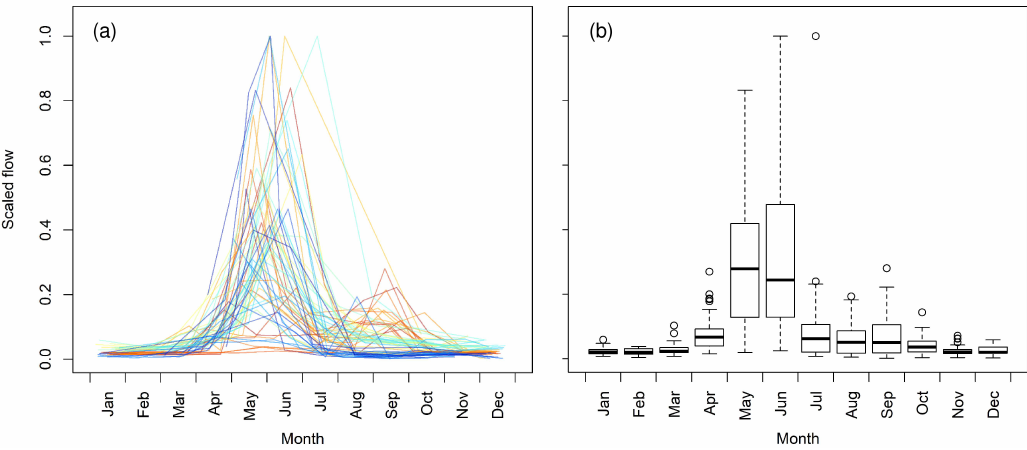
Figure 2. Yearly stream-flow data for 64 randomly selected locations in the study area. The locations were selected from a set in which flow gaging occurred consistently during the year with gaps between measurements of less than 4 months. The year corresponding to each location varies in the period 1983–2012 because gaging campaigns were not consistent. For this same reason, flow gaging observations are not equally spaced in time. The abscissa represents the sampling date, and the ordinate represents a scaled flow, which corresponds to the ratio of streamflow to maximum streamflow recorded at the location. The scaling is performed to improve visualization. Continuous lines connect the streamflow values at a given location and year ( a ), and the box plots represent the distribution of flows in each month ( b ), where the thick horizontal line is the median, the box limits are the first and third quartiles, the whiskers are 1.5 times the interquartile range beyond the quartiles, and the open circles are potential outliers. The data were compiled from the USGS Water-Quality Data for the Nation